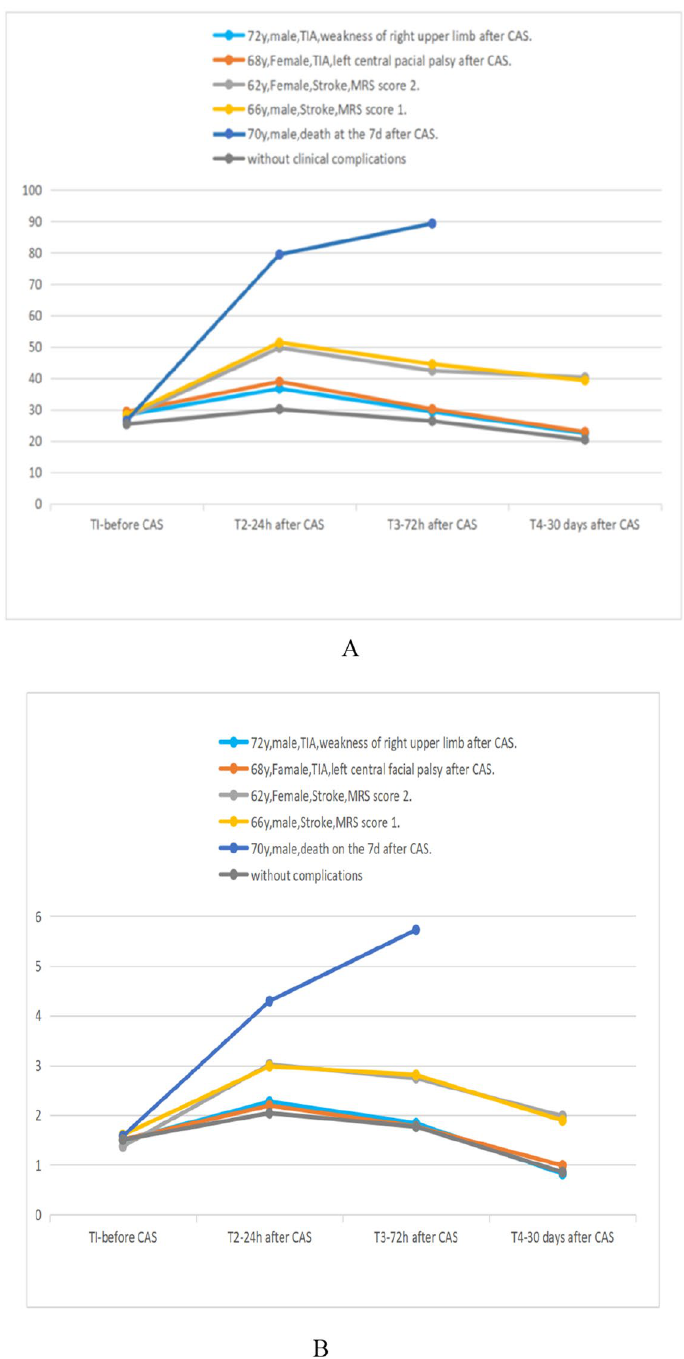
Figure 4. The serum concentrations of GFAP and S100B in five patients with post-operative clinical complications and patients without complications. The serum values of GFAP ( A ) and S100B ( B ) in two patients with TIA increased temporarily at 24 h after operation (T2), and then returned to the basal level at 30 days after operation (T4). For the two patients with stroke and one patient who died, the serum GFAP and S100B increased permanently, and the patient who died maintained a higher level than the patients with stroke at any time points after